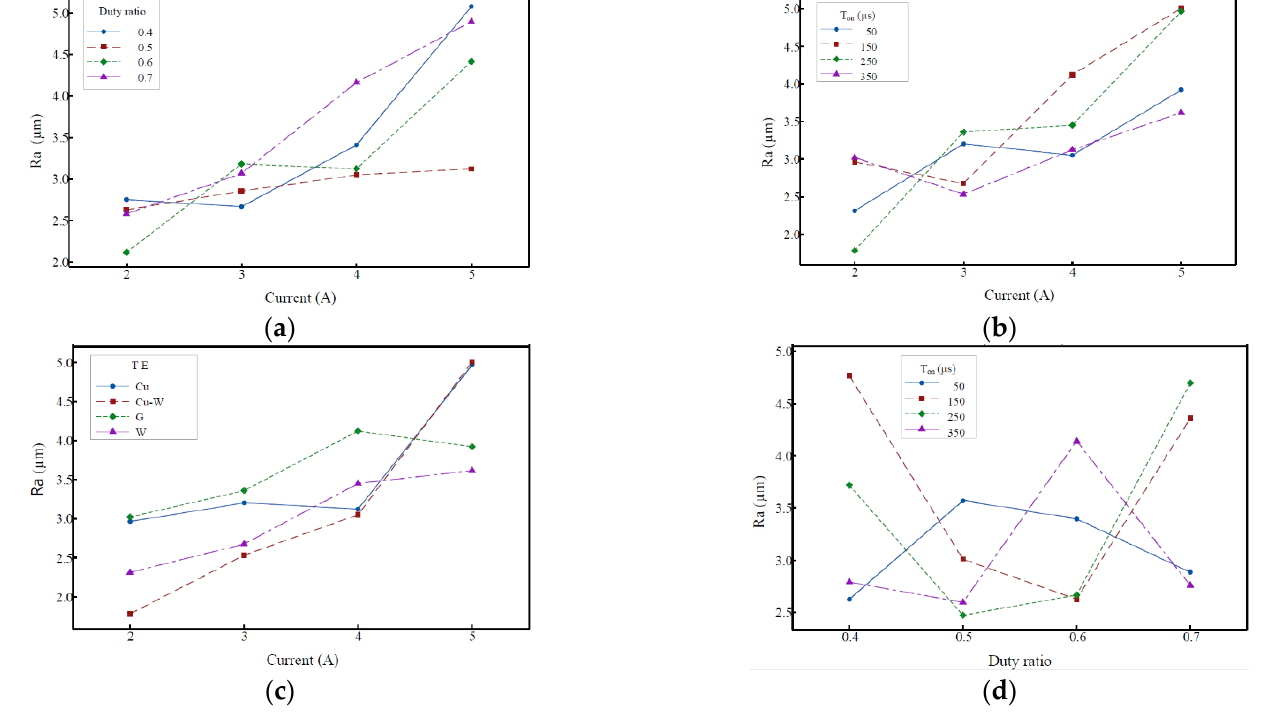
Figure 10. Interaction effect on Ra; ( a ) current and duty ratio on Ra; ( b ) current and pulse duration on Ra; ( c ) current and tool electrode on Ra; ( d ) duty ratio and pulse duration on Ra.